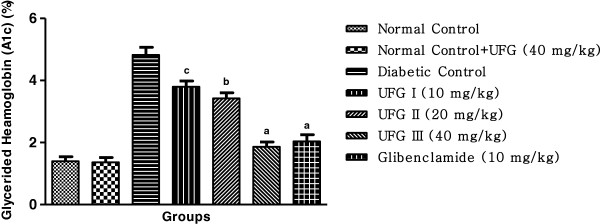
Effect of umbelliferone β-D-galactopyranoside on level of glycated hemoglobin (A1c)(%) at different concentrations on STZ induced diabetic rats, compared to diabetic control group rats; values are mean ± SEM; n = 6;
c
P < 0.05;
b
P < 0.01;
a
P < 0.001; P > 0.05 is considered as non-significant (ns).